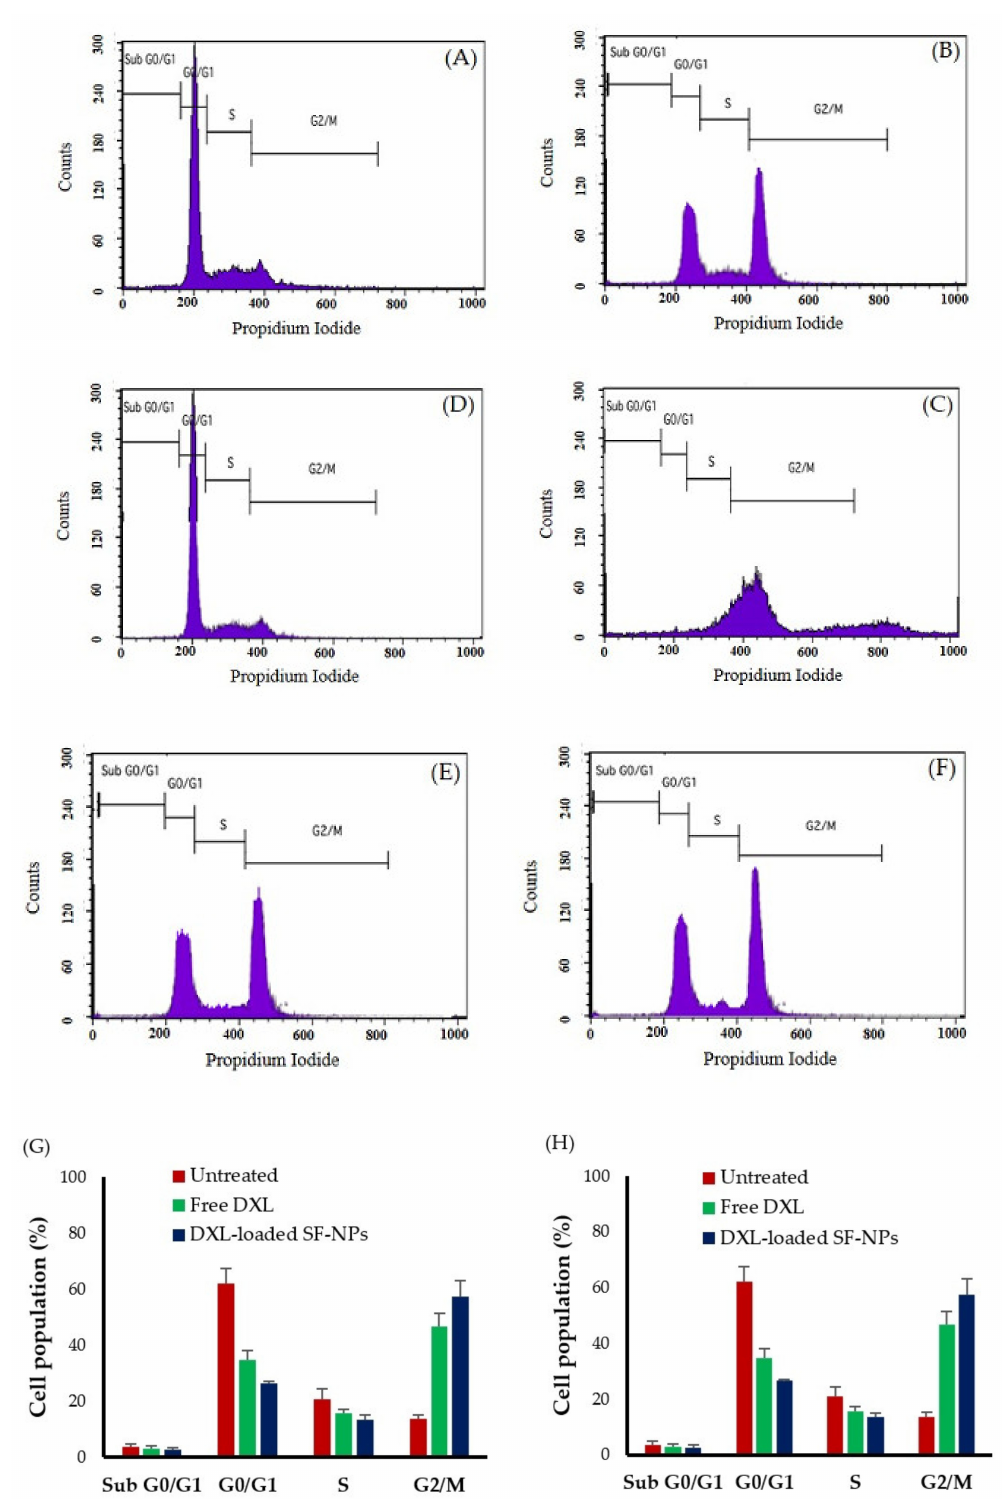
Figure 6. Effect of free DXL and DXL-loaded SF-NPs on cell cycle progression. Flow cytometric analysis of cell populations at different cell cycle stages of ( A ) untreated MCF-7 cells, ( B ) MCF-7 cells treated with free DXL, ( C ) MCF-7 cells treated with DXL-loaded SF-NPs, ( D ) untreated MDA-MB-231 cells, ( E ) MDA-MB-231 cells treated with free DXL, ( F ) MDA-MB-231 cells treated with DXL-loaded SF-NPs. Analysis of the cell cycle of ( G ) MCF-7 cells or ( H ) MDA-MB-231 cells treated with either free DXL or DXL-loaded SF-NP. Data represent mean ±